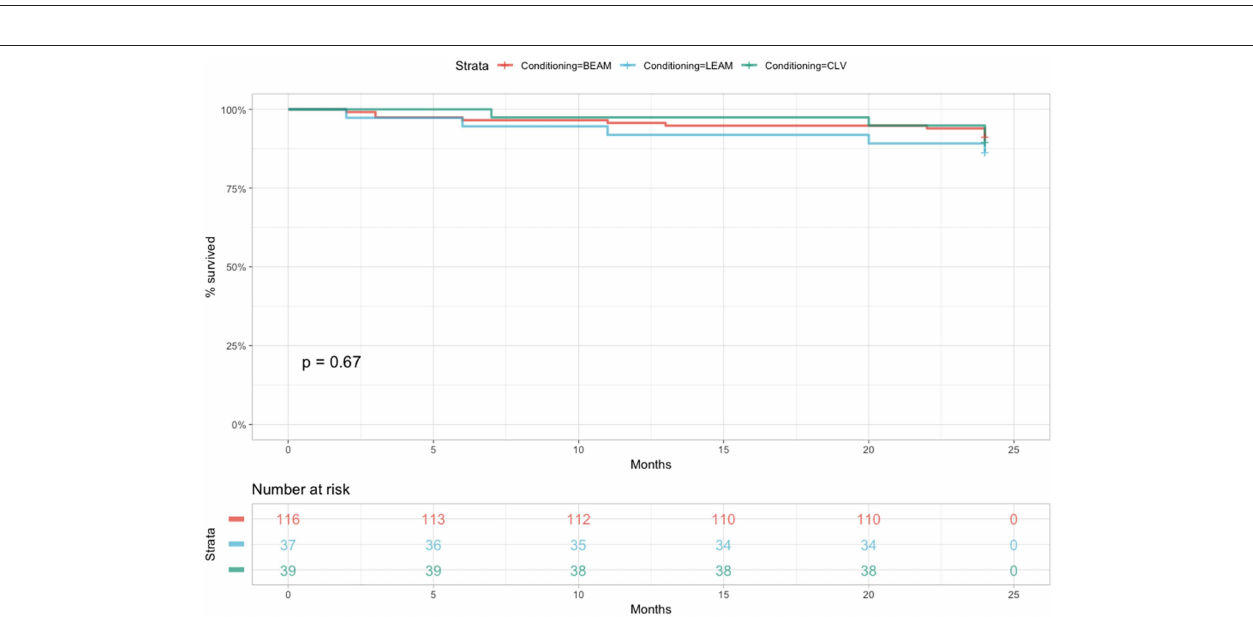
FIGURE 3 | OS comparing the three conditioning chemotherapy regimens at 2 years.